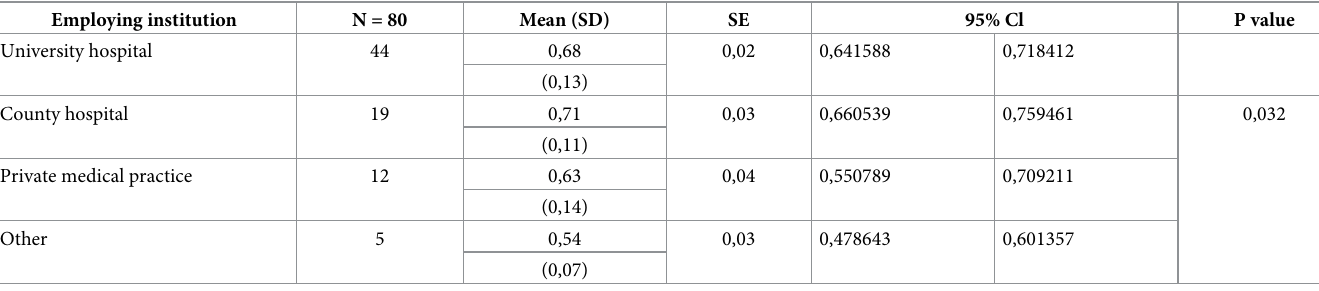
Descriptive analysis and data quality, by a number of participant (N), mean, standard deviation (SD), standard error of the mean (SE), 95% confidence interval (95%